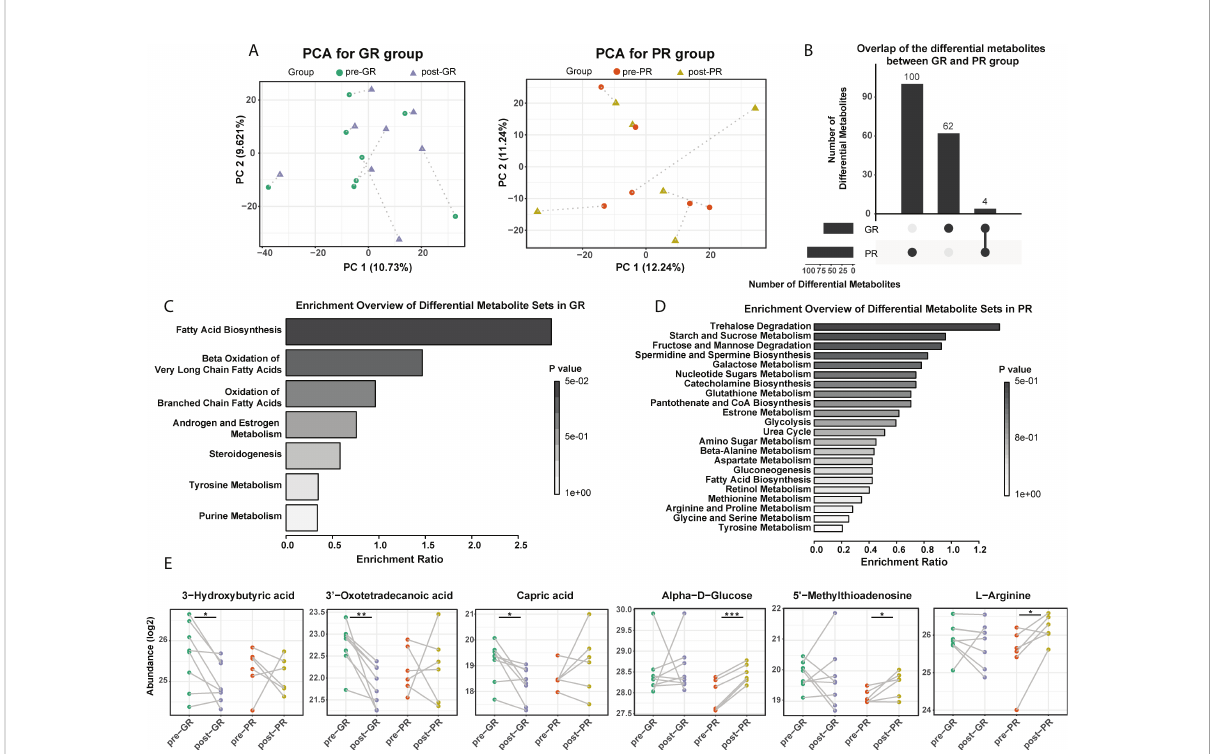
FIGURE 3 Comparison of serum metabolome before and after MTX treatment. (A) PCA plot for the GR and the PR, respectively. (B) Overlap of the changed metabolites after MTX treatment in the GR and the PR groups. (C,D) Functional enrichment of differential metabolites in the GR (C) and the PR group (D) , respectively. (E) Representative differential metabolites mapped to fatty acid biosynthesis, glucolipid metabolism, and amino acid metabolism. Signi fi cance is determined by using VIP of PLS-DA > 1, combined with |log2FC| ≥ 0.25 and the paired Student ’ s t -test p -value < 0.05. *Paired Student ’ s t -test p < 0.05; **paired Student ’ s t -test p < 0.01; ***paired Student ’ s t -test p <